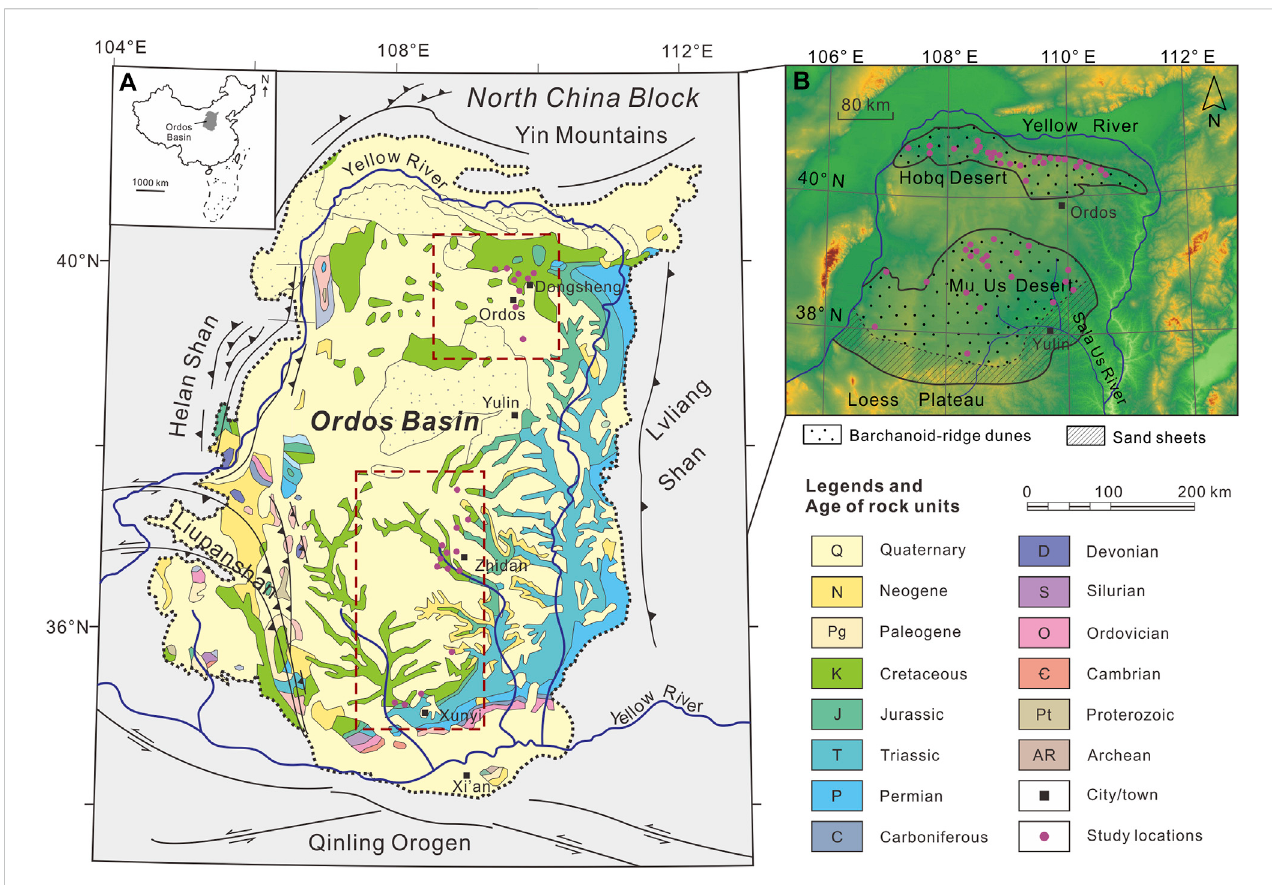
FIGURE 1 (A) Geological map of the Ordos Basin. (B) Digital Elevation Model (DEM) of the modern deserts (Hobq Desert and Mu Us Desert) in the Ordos Basin. Dashed box: study area; circle: data measurement outcrop locations.